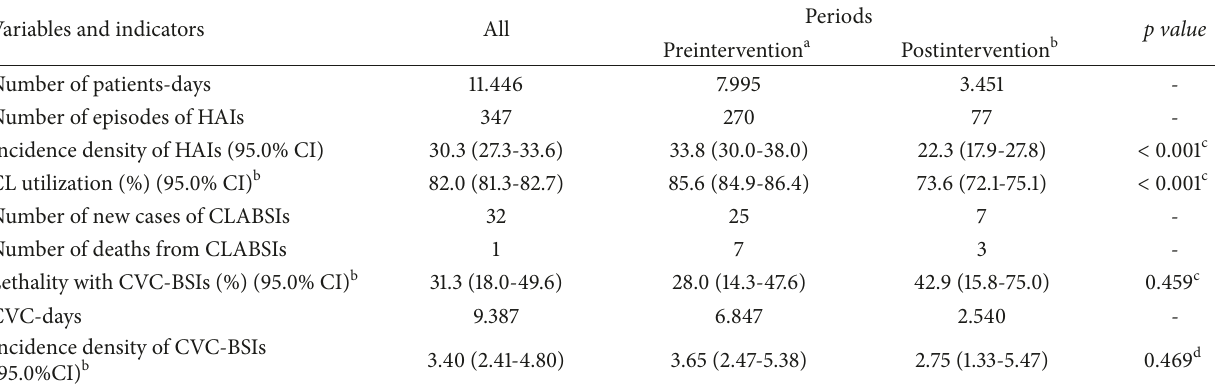
Table 2: Evaluated variables and indicators in the adult ICU. Central Brazil. 2012-2015.